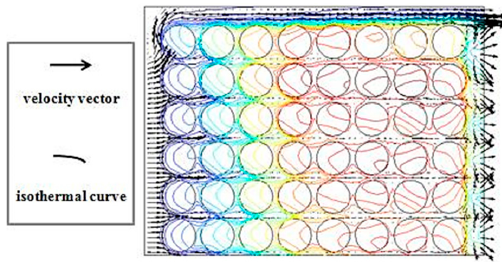
Figure 2. Distribution of the velocity vectors and isothermal curves at the rate of 1.0 m/s.